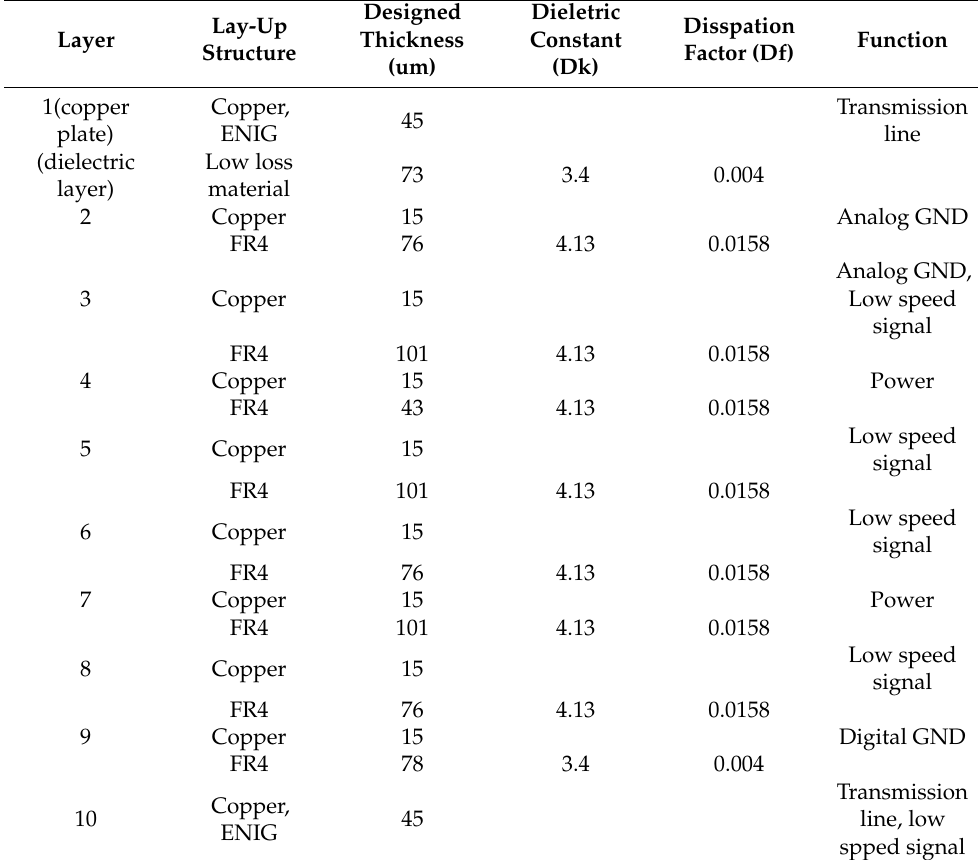
Table 3. QSFP28 PAM4 printed circuit board (PCB) layer